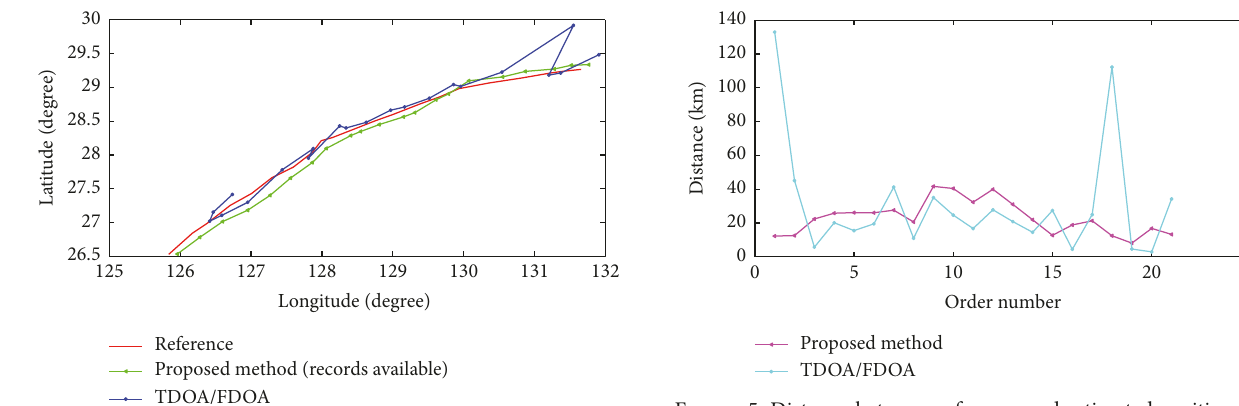
Figure 3: Examples of estimated vessel positions for records availability scenario.